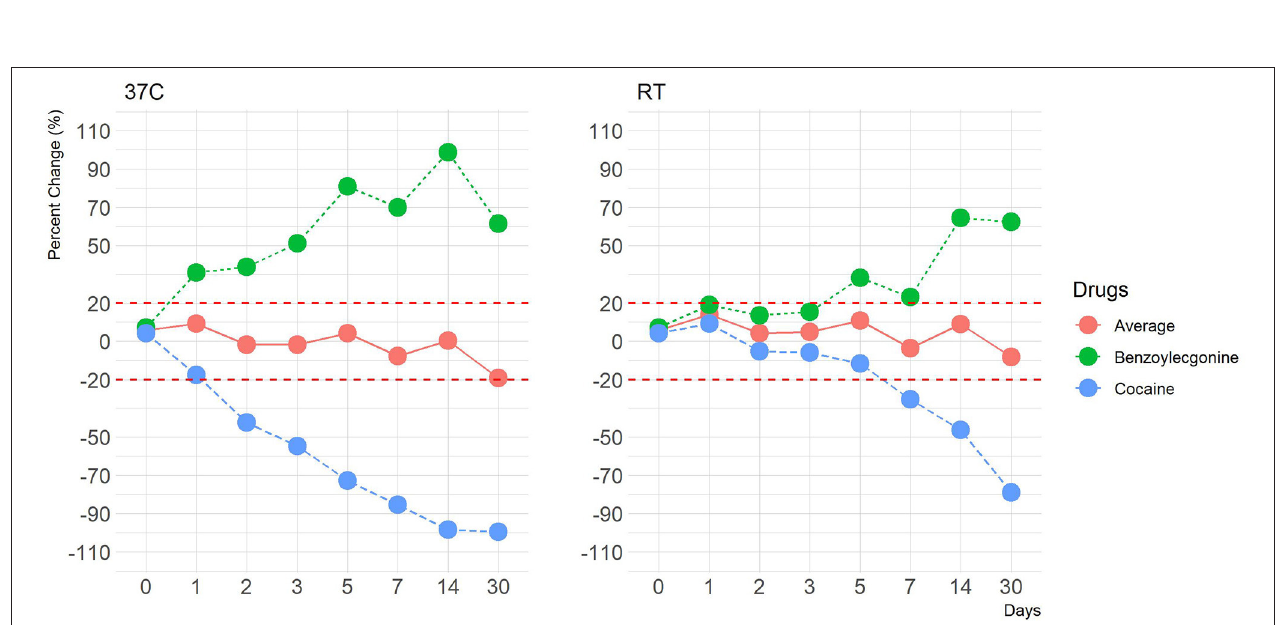
FIGURE 4 | A line plot depicting percentage differences at 37 ◦ C and at room temperature (–50% cut-off) of average cocaine and benzoylecgonine concentration values. The y-axis represents percentage change, and the x-axis represents time points in days. Red dotted lines represent ± 20% cut-off.